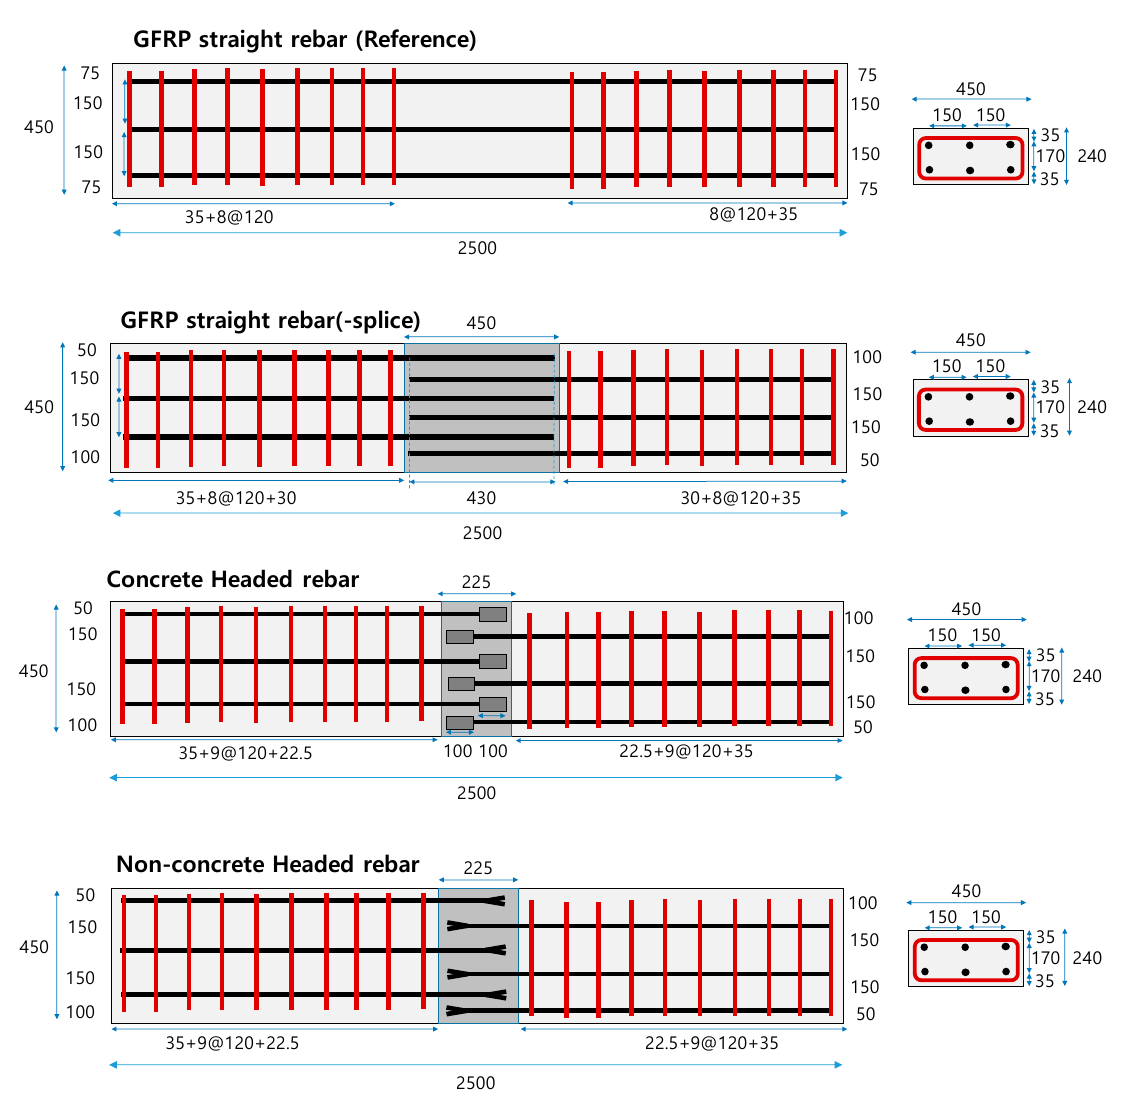
Figure 10. Details of the connected precast concrete deck.